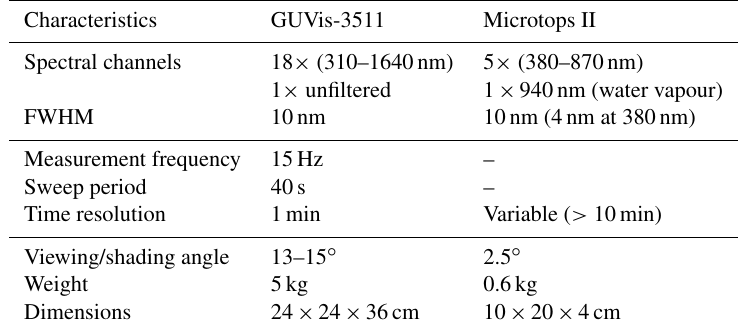
Table 1. Technical specifications of the GUVis and Microtops instruments. FWHM indicates full width at half